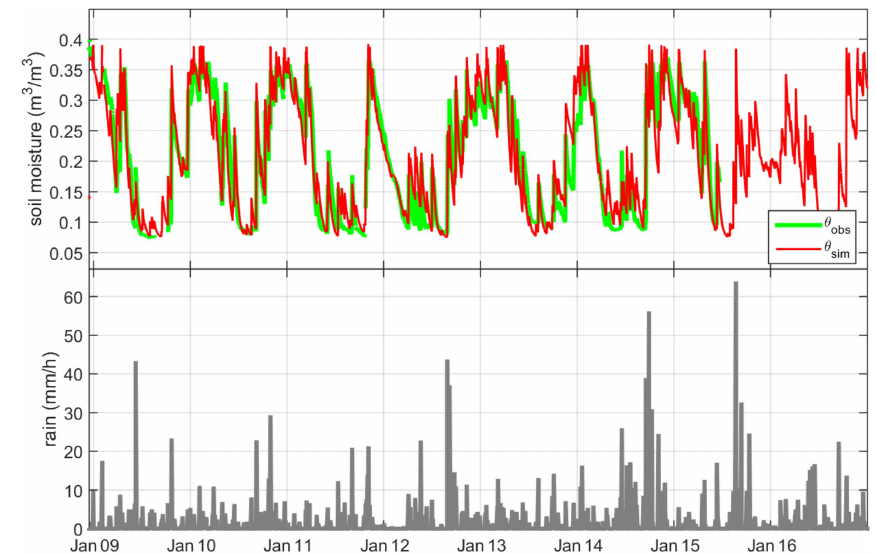
Figure 6. Soil moisture simulation at the Villevielle station.